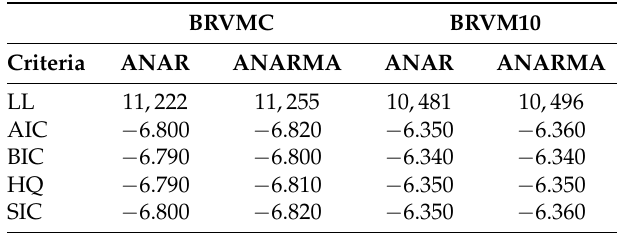
Table 3. Log-likelihood and information criteria for model